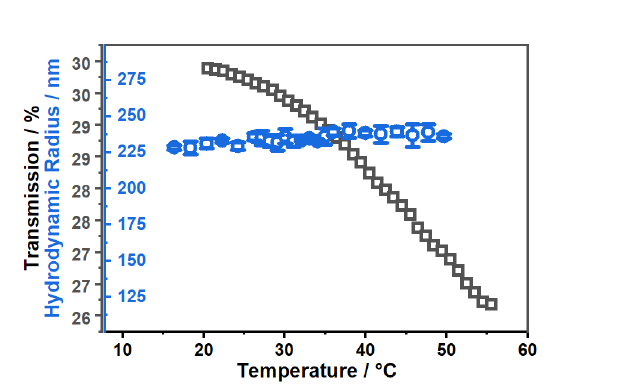
Figure 6. Comparison of the temperature-dependent development of the hydrodynamic radius (blue) measured by PCS at fixed scattering angle and the transmission (black) of the copolymer microgel suspension in EtOH measured by UV/Vis